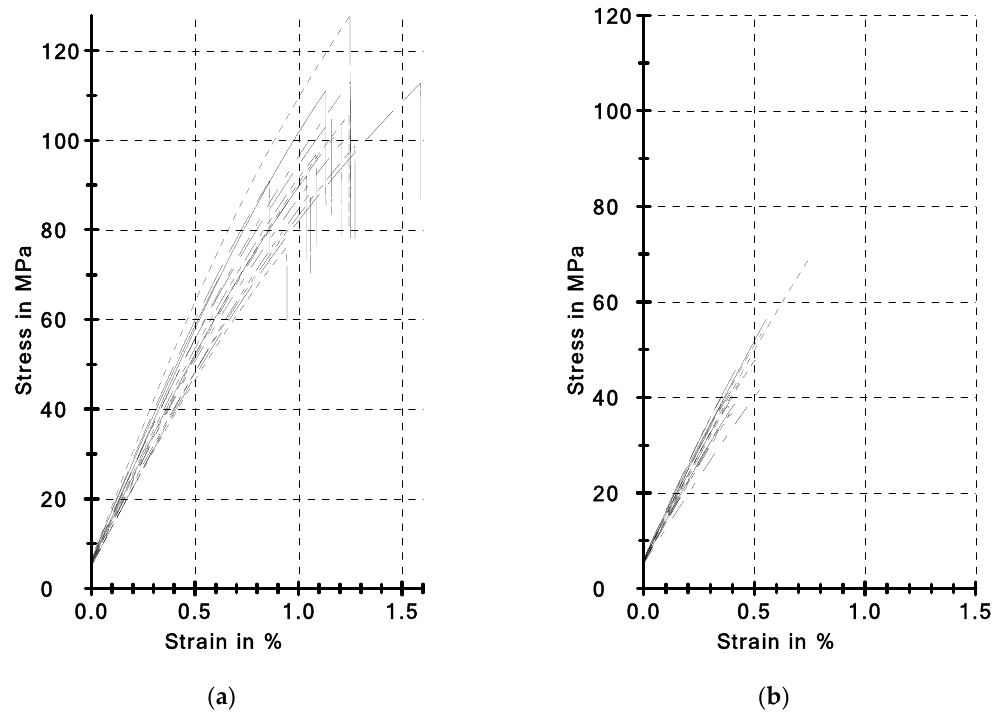
Figure 5. Comparison of σ - ε characteristics obtained in the TFS test: ( a ) Ex-nano (G), ( b ) Ex-nano (G) after 10 4 thermocycles.